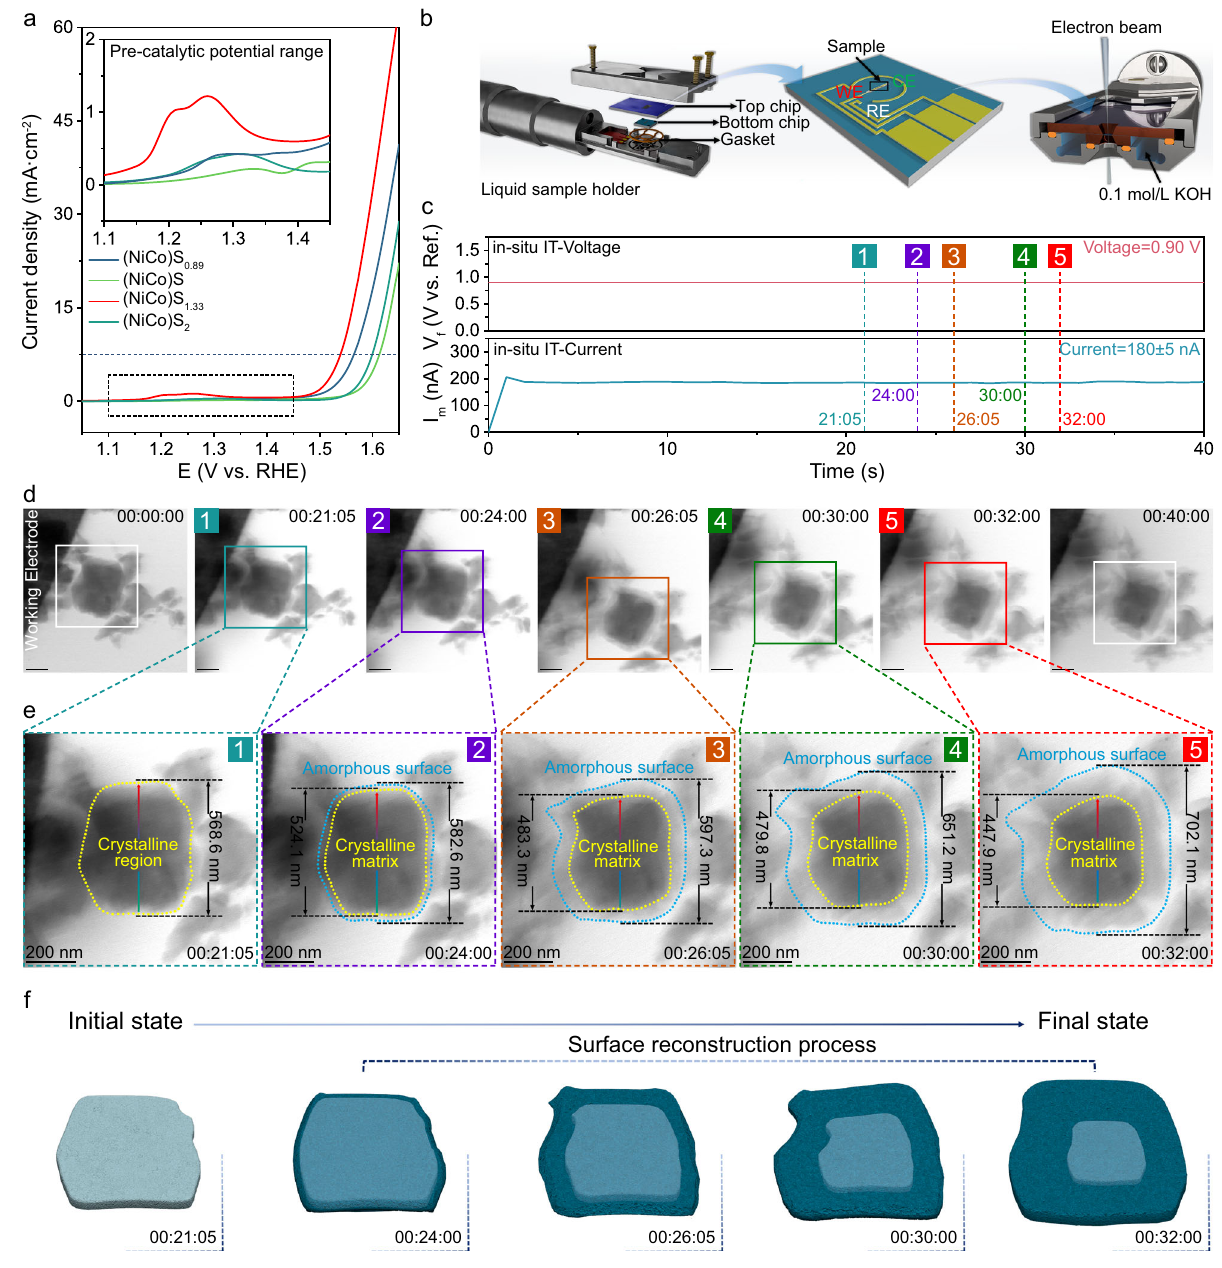
Fig. 2 | Real-time observation of the surface reconstruction process. a iR- corrected LSV at a scan rate of 5mVs − 1 . b Schematic diagram of in-situ TEM experiment.WE(red),CE(green)andRE(white)representtheworkingelectrode,a counter electrode and a reference electrode, respectively. c The applied potential